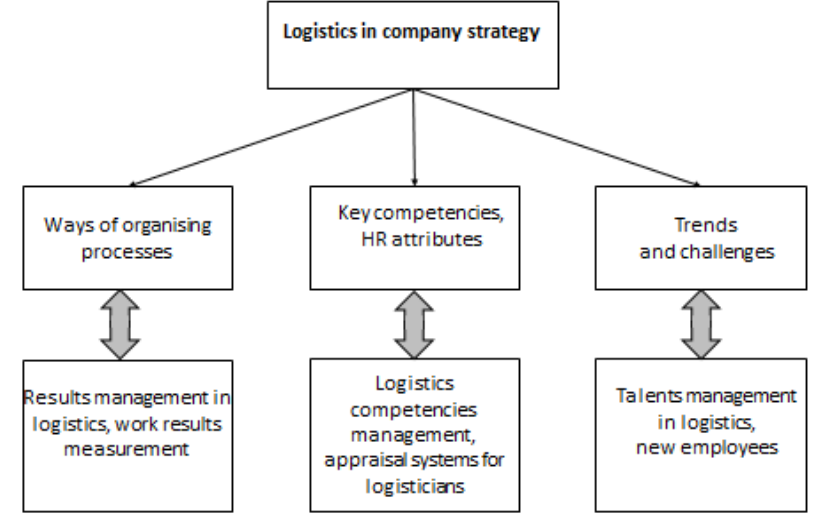
Figure 7. A model of the personnel function delivery in company logistics. Source: authors’ original work.